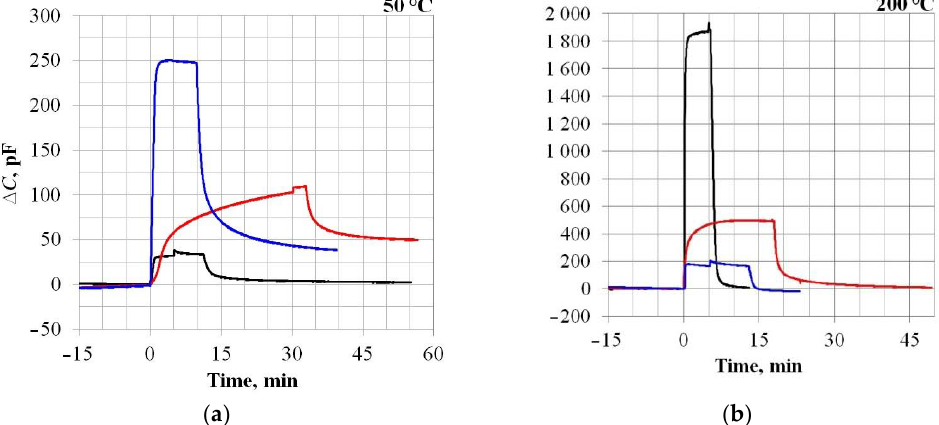
Figure 3. An example of the sensors ’ dynamic characteristics exposed to a 1000 ppm H₂ at different operating temperatures: 50 °C ( a ) and 200 °C ( b ). The beginning of the gas concentration supply corresponds to zero on the abscissa. The gas feed duration varied depending on the readings’ stabilization rate. Black lines—Sample No. 1; red lines—Sample No. 2; and blue lines—Control sample.